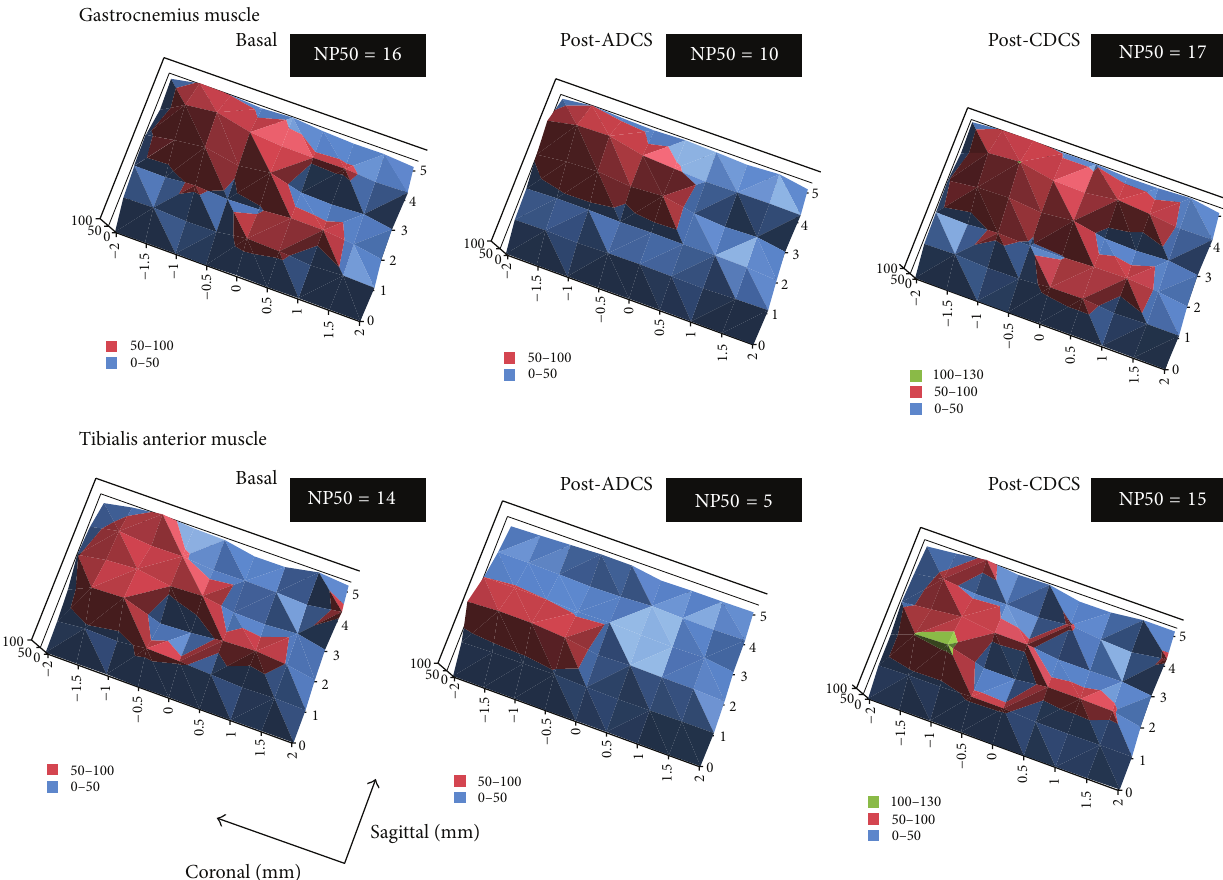
Figure 4: Motor maps corresponding to responses recorded in left gastrocnemius muscle (upper panels) and left tibialis anterior muscle (bottom panels), ipsilaterally to the site of cerebellar direct current stimulation for one rat. Data are represented using contour plots with 𝑋𝑌𝑍 coordinates. 𝑥 -axis and 𝑦 -axis refer to sagittal and coronal coordinates, respectively (coordinates of Bregma: 0/0mm). Intensities of corticomotor responses are illustrated in 𝑧 -axis using a linear scale. The so-called “hot spots” (shown in red) are identified. Stimuli are applied every mm in the sagittal axis and every 0.5mm in the coronal axis (matrix of 6 × 9 = 54 sites of stimulation). Coordinates of stimulation are established using the stereotactic frame. Left panels: recordings in basal condition; middle panels: recordings after application of anodal direct current stimulation (post-ADCS); right panels: recordings after application of cathodal direct current stimulation (post-CDCS). Maximal responses obtained at baseline are set at 100%, for both the gastrocnemius muscle and tibialis anterior muscle. ADCS induces a reorganization of the corticomotor map, restricting the representation of the most intense motor responses around the hot spot (“focusing effect”) and reducing the intensity of the hot spot. By contrast, application of CDCS redistributes the representation of the most intense motor responses and increases the magnitude of the hot spot. The number of peaks in the 𝑍 axis with values above 50% of maximal corticomotor responses (NP50) is indicated in the upper right corner of each panel. Note the clear drop after ADCS and the slight increase after CDCS, as compared to